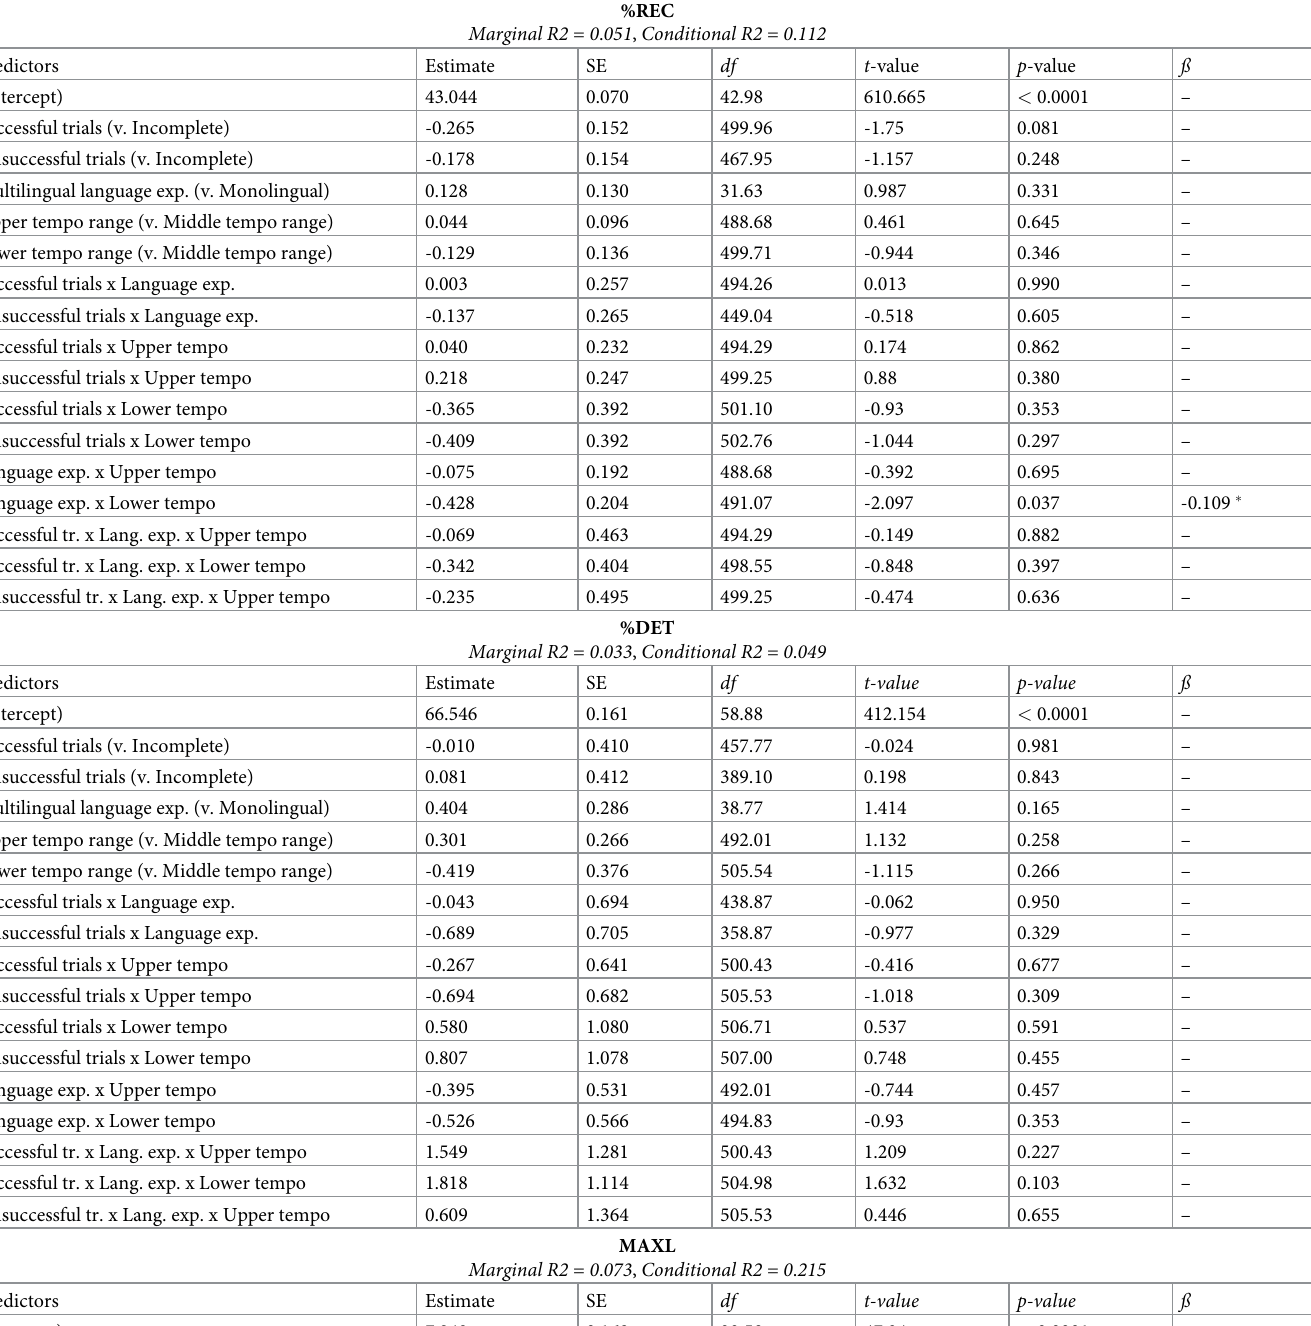
Table 2. Linear mixed effect model results for general MdRQA with trial type, language experience, and tempo range as predictors of %REC, %DET, and MAXL. Each MdRQA metric was predicted using a separate model. Marginal and conditional R 2 for each model included below each model label. Effect sizes provided as stan- dardized estimates ( ß ) for statistically significant predictors. As noted in the Model Specifications section, the use of deviation coding yields k -1 variables that test the differ- ence between a given level of the categorical variable and the reference level. General MdRQA models used the incomplete trials, monolingual language experience, and middle tempi as reference categories; for more on mathematical interpretation of deviation-coded interaction terms, see Barr et al. (2013)